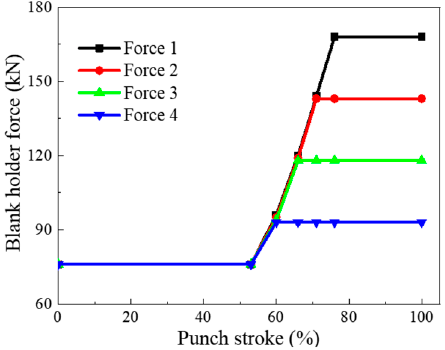
Figure 5. Load curve of blank holder force under force variation.